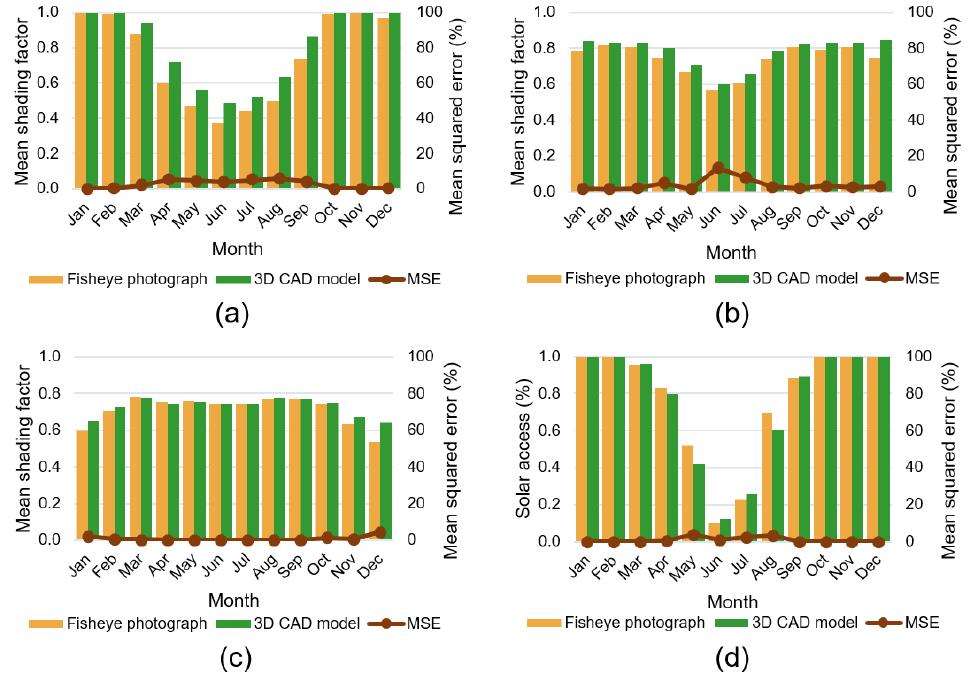
Figure 16. Mean shading factors for each month at survey points ( a ) C1, ( b ) C2, ( c ) C3, and ( d ) C4. Table 5. Mean shading factors over one year, in May–October, and in November–April at 12 survey